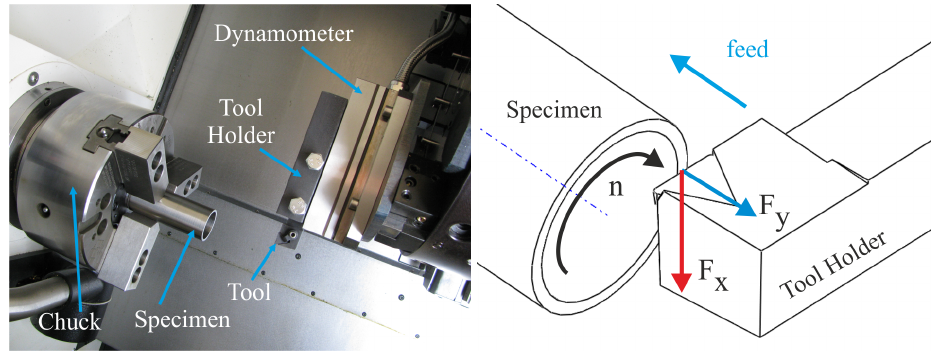
Figure 17. Experimental setup in orthogonal